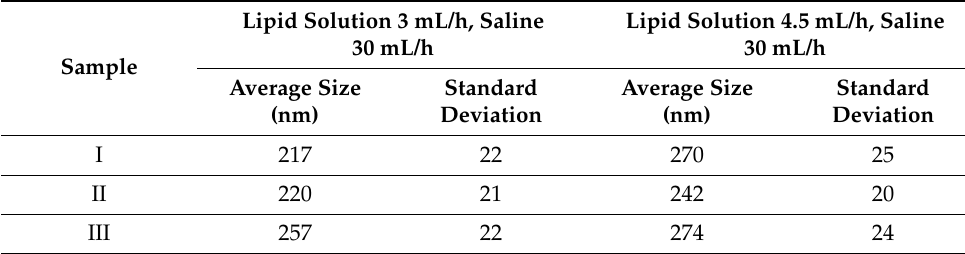
Figure 15. Liposome size depending on flow rate for lipid solution.